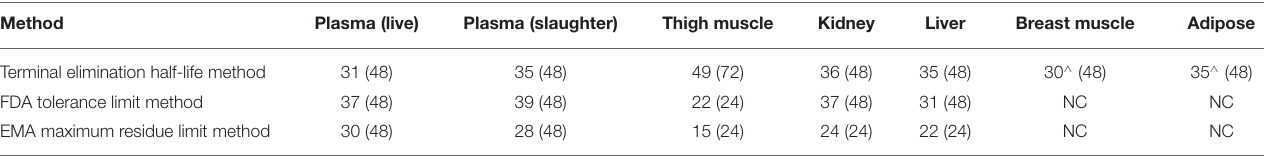
TABLE 5 | Estimated preliminary* extra-label drug use (ELDU) withdrawal intervals (WDIs) for meloxicam administered to chickens at 1 mg/kg IV once. Method